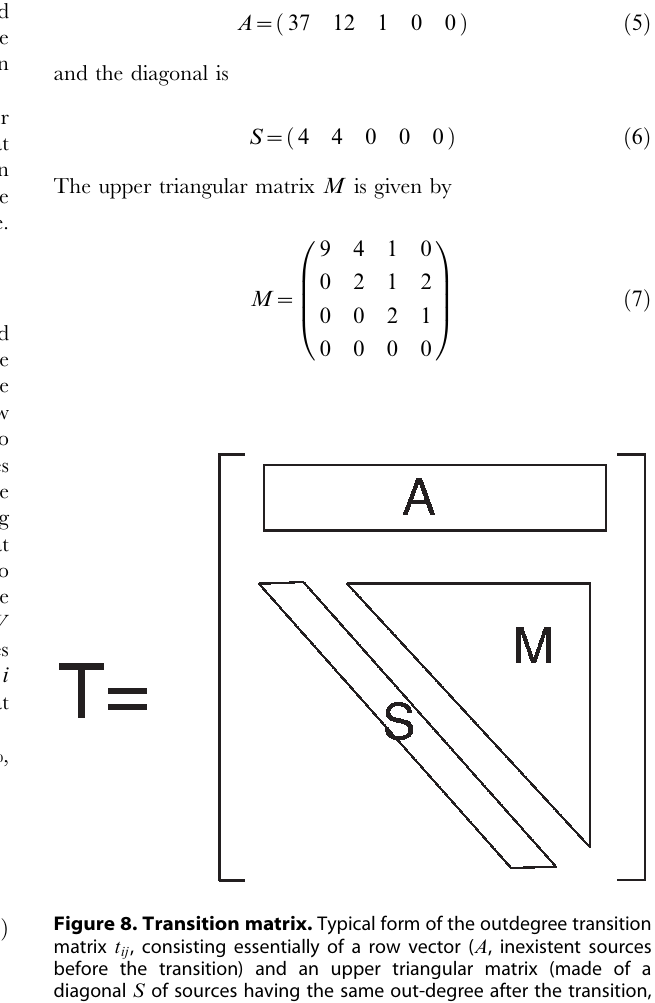
Figure 8. Transition matrix. Typical form of the outdegree transition matrix t ij , consisting essentially of a row vector ( A , inexistent sources before the transition) and an upper triangular matrix (made of a diagonal S of sources having the same out-degree after the transition, and a submatrix M of sources whose out-degree increases after the